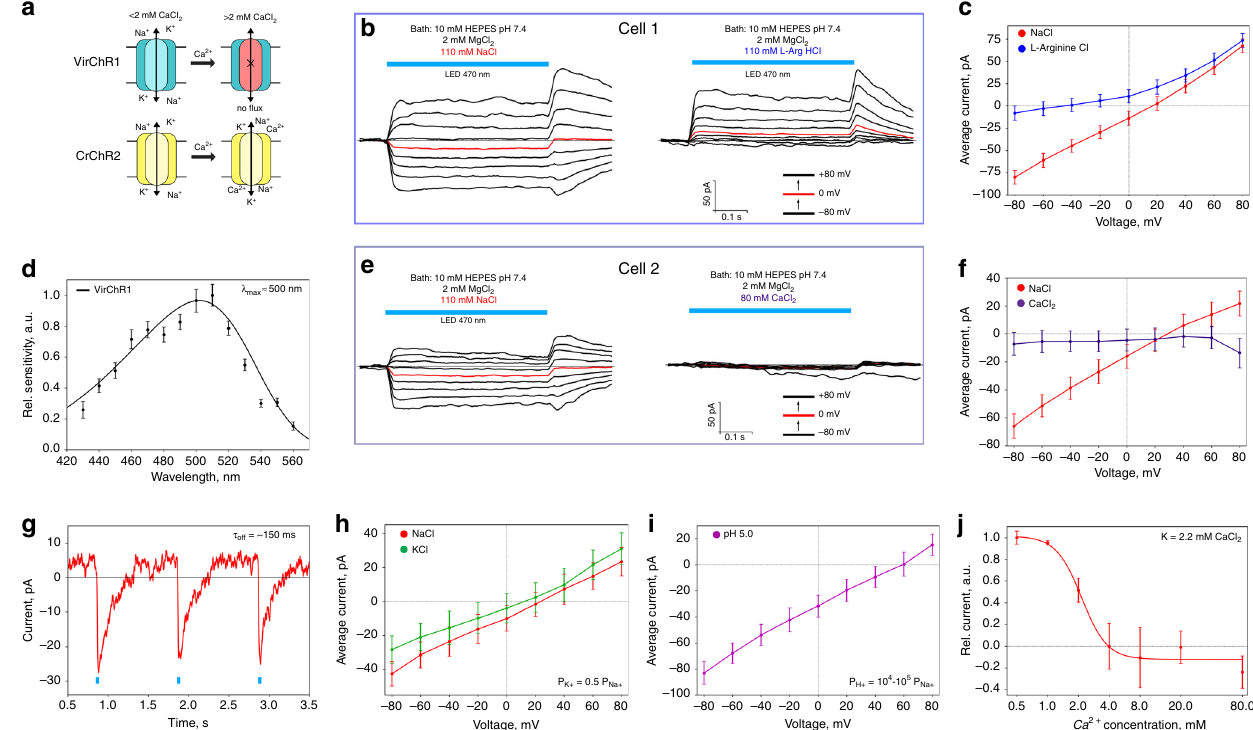
Fig. 3 Ion selectivity and physiological features of VirChR1. a Schematic comparison of VirChR1 and Cr ChR2 ion channeling activity under different calcium concentrations, membrane boundaries are shown schematically as black horizontal lines. b Voltage-clamp records from n = 1 representative SH- SY5Y cell, expressing VirChR1 with (left) 10 mM HEPES pH 7.4, 110 mM NaCl, 2 mM MgCl 2 and (right) 110 mM L-arginine hydrochloride replacing NaCl